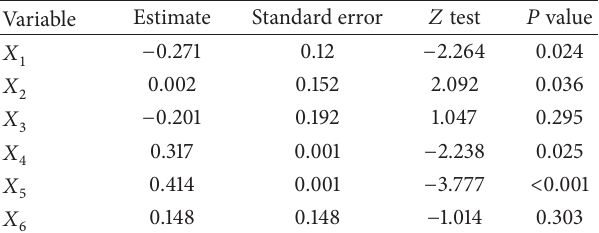
Table 4: Model estimation.